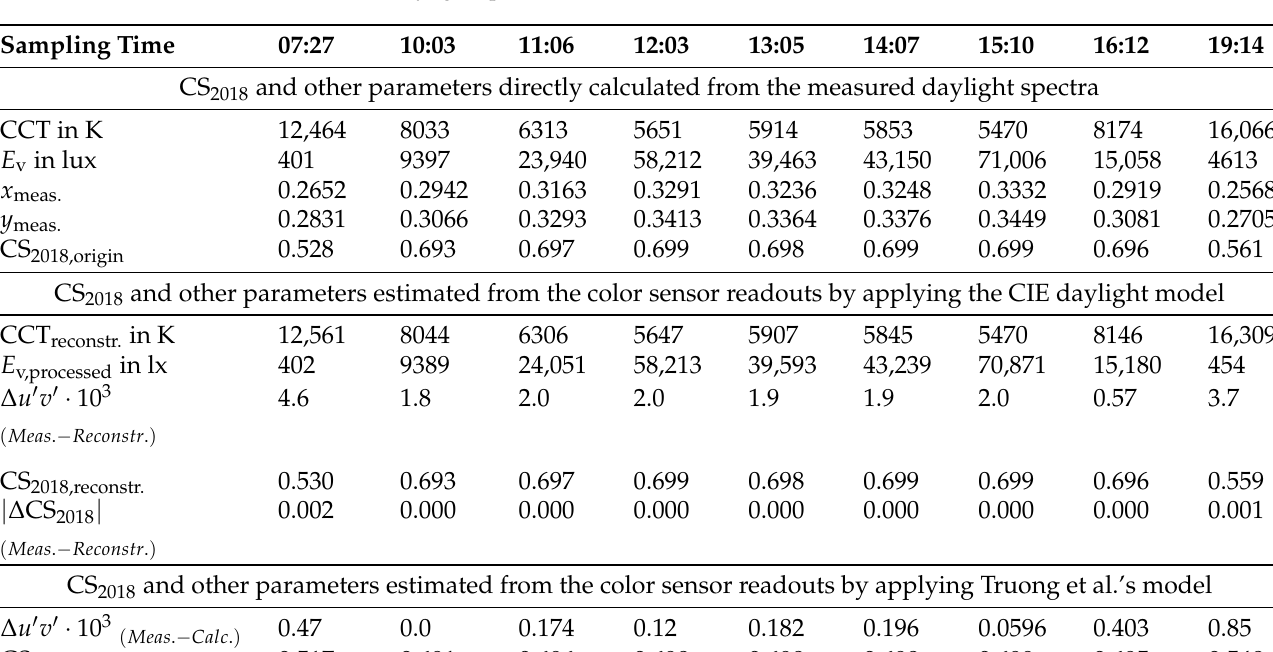
Table 7. Comparison between the color sensor’s CS predictions (CS 2018,reconstr. ) and Rea et al.’s origi- nal model (CS 2018,origin ) for a second set of measured daylight spectra not included in the training data. The measurement uncertainty for CS 2018,origin is of the order of ± 8%. Here, the annotation “ ( Meas . − Reconstr . ) ” indicates that the given accuracy estimates | ∆ CS 2018 | and colorimetric pre- diction errors ∆ u (cid:48) v (cid:48) are determined by comparing the corresponding quantities derived from the performed radiometric measurements (i.e., “ Meas .”) and the application of Rea et al.’s model for- malism to those obtained by processing the sensor readouts for the subsequent application of the CIE daylight reconstruction method (i.e., “ Reconstr .”) as proposed in this work. The annotation “ ( Meas . − Calc . ) ”, on the other hand, again denotes the use of Truong et al.’s approximation method also for daylight